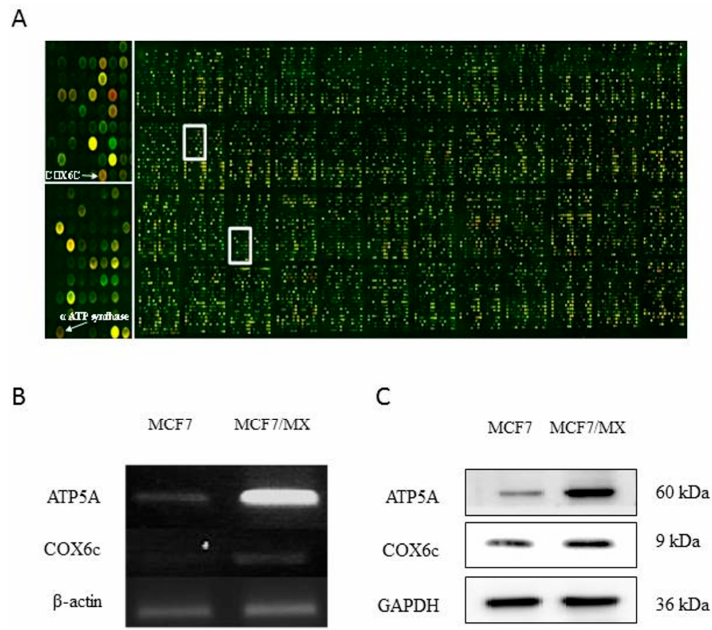
Figure 2. The hybridization on the microarray chip. ( A ) Identification of genes potentially involved in the multidrug resistance (MDR) phenotype. RNA from MCF-7 cells and MCF-7/MX cells was reverse transcribed and labeled with Cy3-dCTP (MCF-7; green ) and Cy 5-dUTP (MCF-7/MX; red ). Genes up-regulated in MCF-7/MX appear red and those that are down-regulated appear green. A portion of the cDNA microarray is magnified on the right to show the element representing the ATP synthetase α subunit ( α ATP synthase) and COX6C genes, which are over-expressed only in the multidrug-resistant MCF-7/MX cells; ( B ) mRNA level of ATP synthetase α subunit ( α ATP synthase) and cytochrome c oxidase subunit VIc (COX6C) in MCF-7 and MCF-7/MX cell lines; ( C ) Protein level of ATP synthetase α subunit ( α ATP synthase) and cytochrome c oxidase subunit VIc (COX6C) in MCF-7 and MCF-7/MX cell lines. Table 1. Genes with elevated expressions in MCF-7/MX cells.